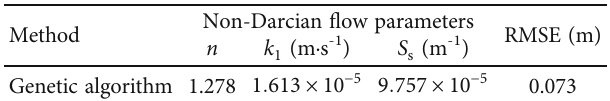
Figure 6: Measured observation borehole hydraulic head h (black points) and calculated hydraulic head by the non-Darcian fl ow model (red line) of the fi rst test. Table 1: The genetic algorithm inversion of non-Darcian fl ow parameter